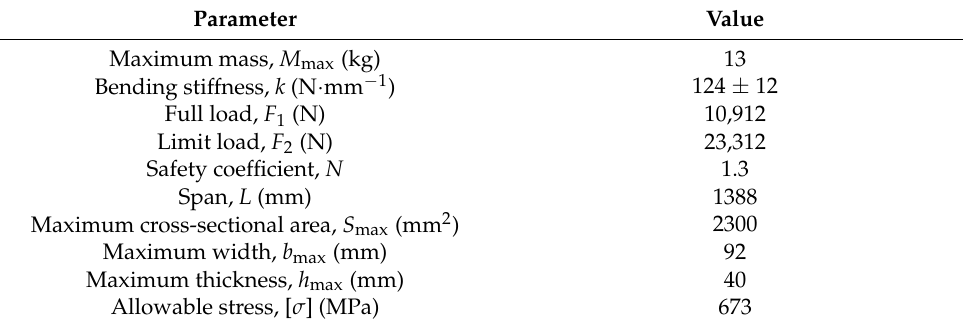
Table 1. Design requirements of the composite leaf